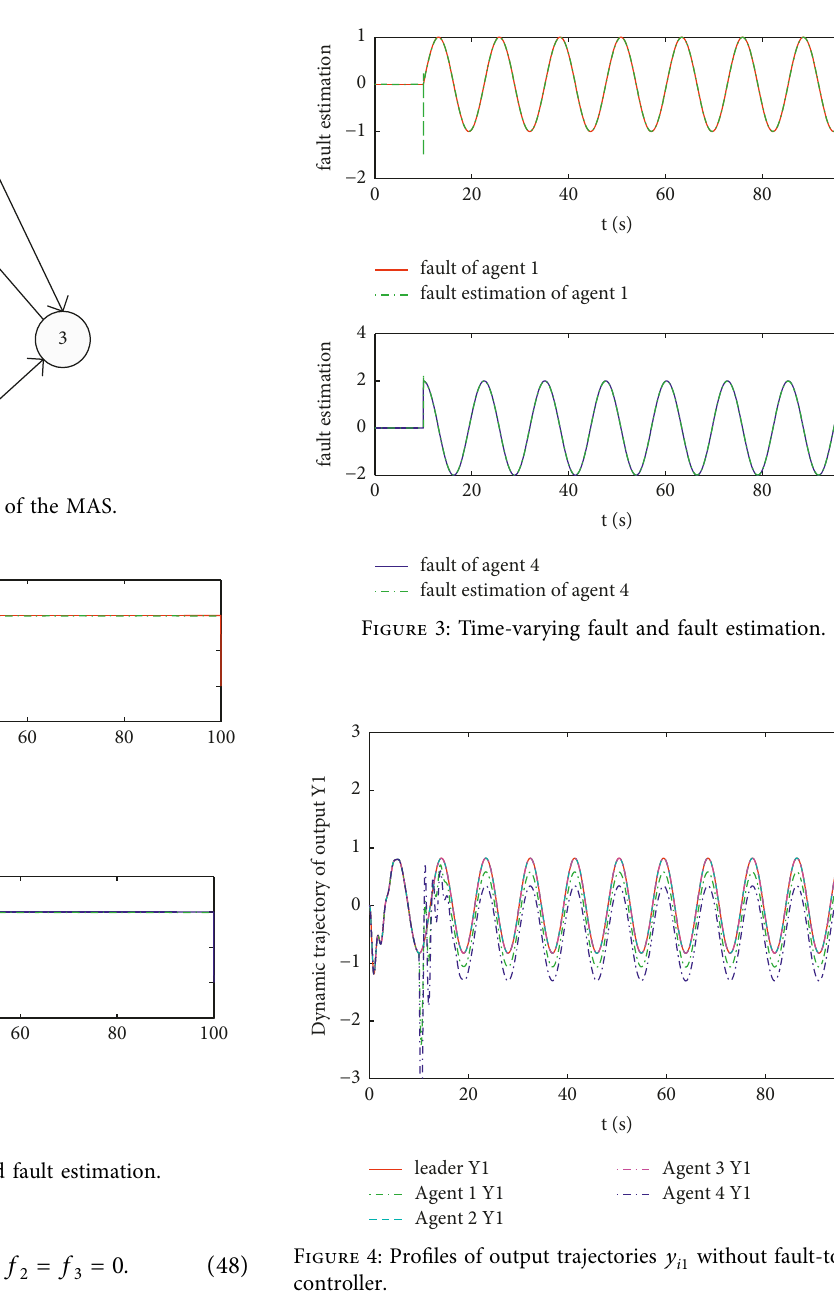
i 1 without fault-tolerant